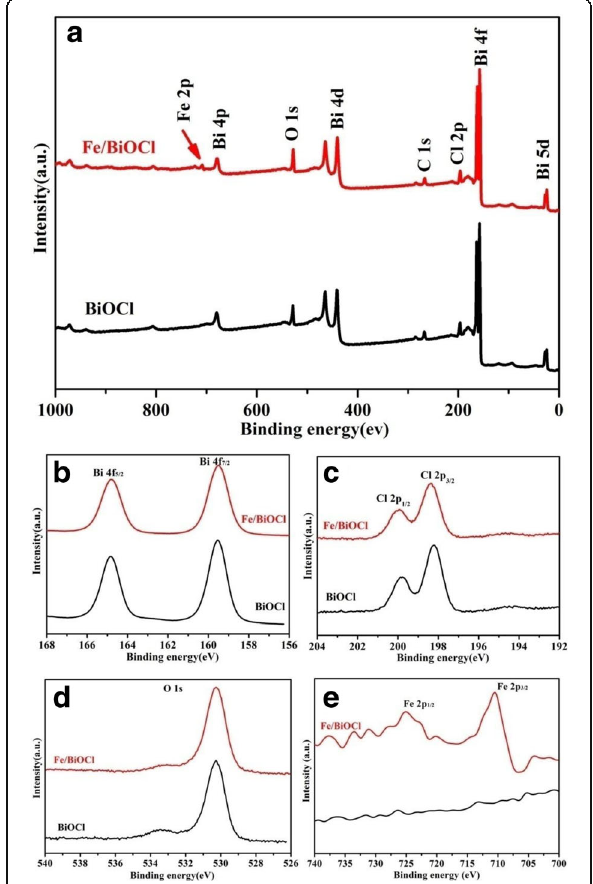
Fig. 5 The XPS spectra of BiOCl and Fe/BiOCl (0.25). a Survey, b Bi 4f, c Cl 2p, d O 1s, and e Fe